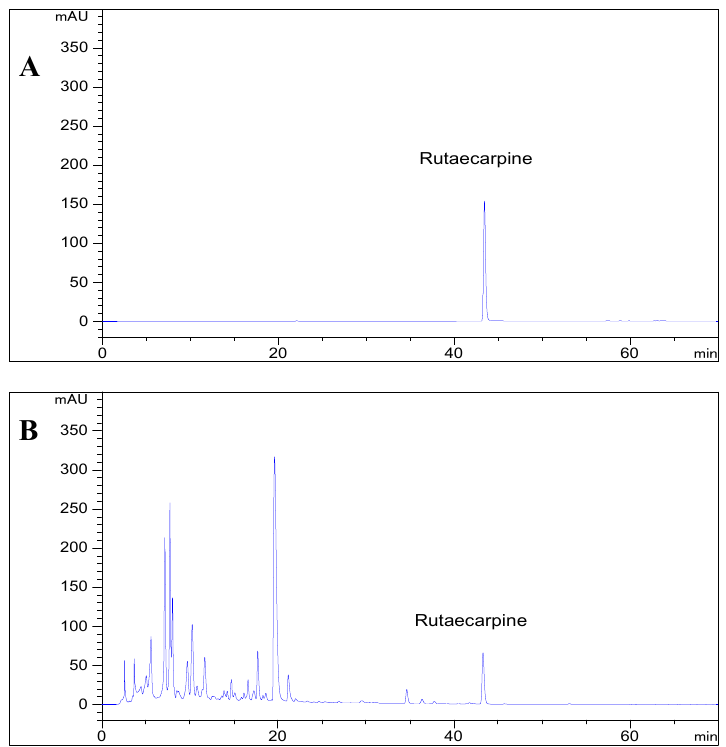
Figure 2. Typical HPLC chromatograms of ( A ) the reference compound of rutaecarpine, and ( B ) the extract of T . ruticarpum . HPLC conditions: Column, Zorbax SB-C18 250 mm × 4.6 mm I.D.; column temperature, 35 °C; mobile phase, water with 0.2% phosphoric acid ( A ) and acetonitrile ( B ); gradient program, 0–20 min, 10–30% B; 20–60 min, 30–70% B; 60–70 min, 70% B; flow rate, 1.0 mL/min, detection wavelength, 345 nm.